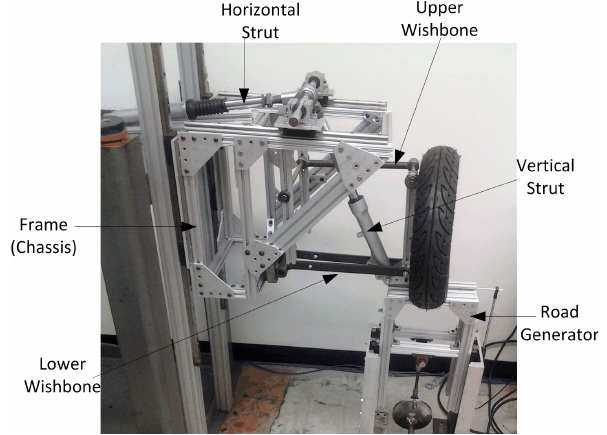
Figure 5. Box Plot: Car Body Acceleration.